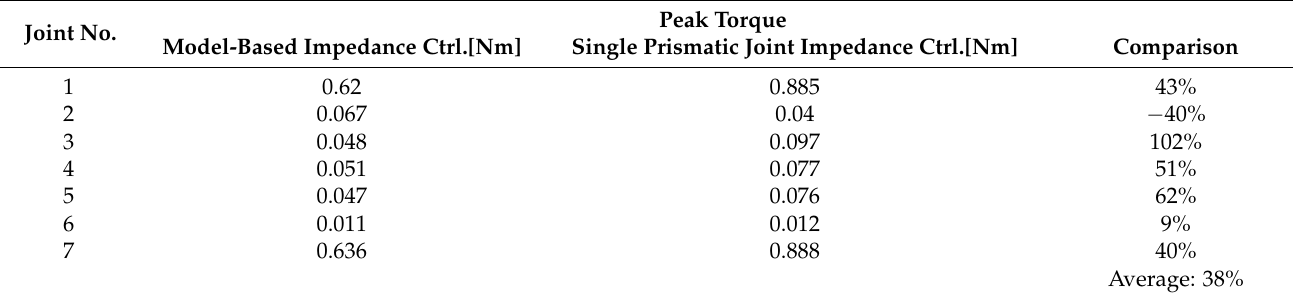
Table 2. Comparison of peak torque loads in robot joints. Peak Torque Joint No. Model-Based Impedance Ctrl.[Nm] Single Prismatic Joint Impedance Ctrl.[Nm]